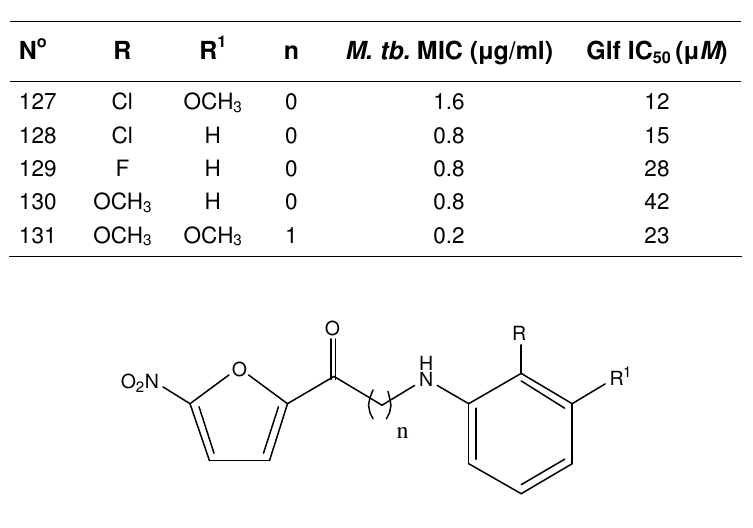
FIGURE 13. Structures of nitrofuranylamides 127 – 131